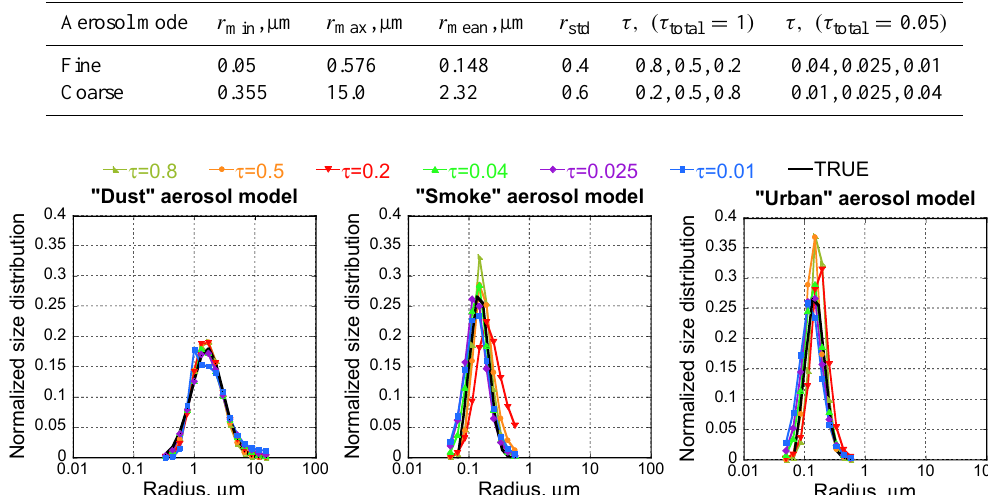
(Goddard Space Flight Center), Banizombou and Solar Vil- lage AERONET sites correspondingly, where the listed types of the aerosols usually dominate in aerosol load ( Dubovik et al., 2002a). The values for spectral channels λ = 0.355, 0.532 and 1.064 µm corresponding to lidar mea- surements were obtained by the extrapolation.